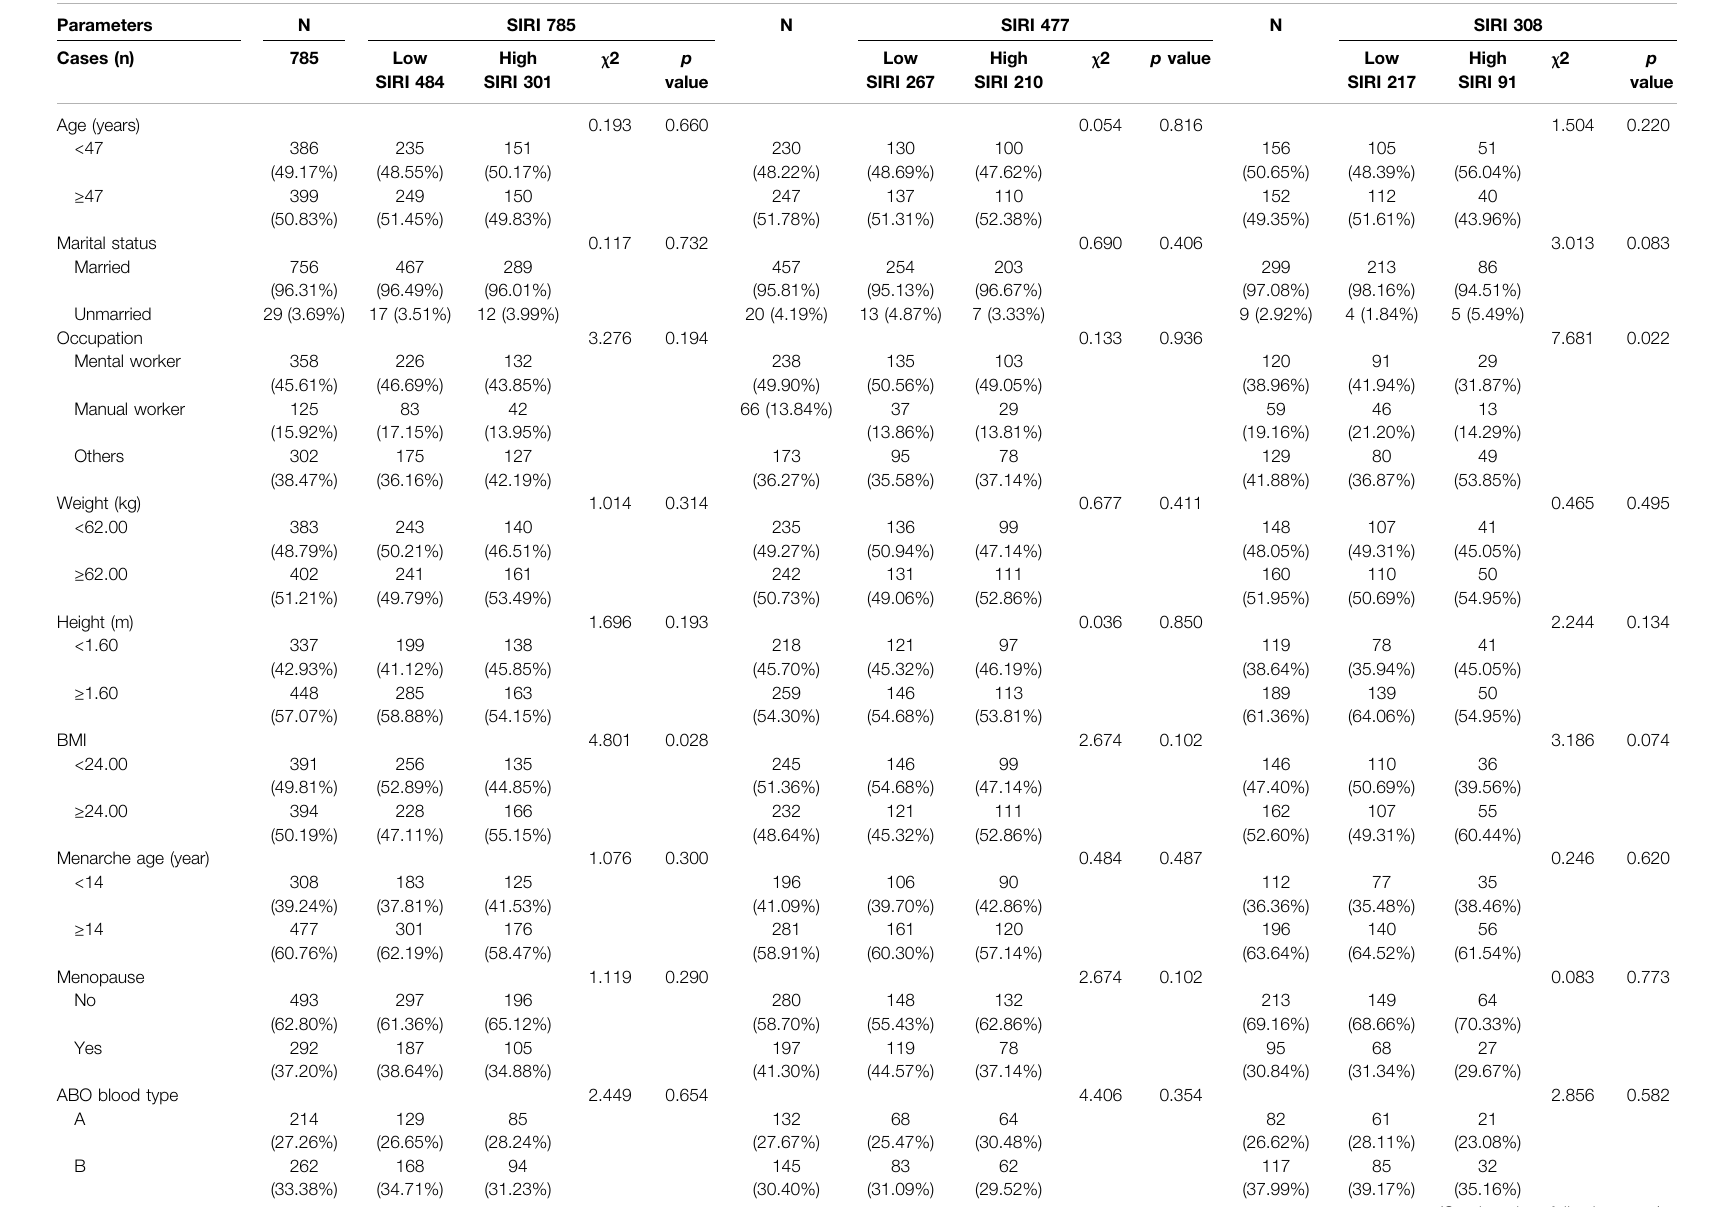
TABLE 1 | Demographic and clinicopathologic characteristics of 785 patients with breast